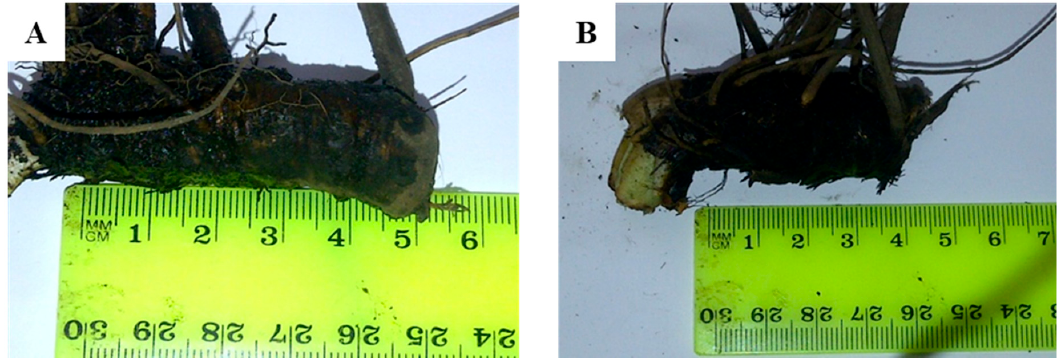
Figure 1. Different lengths of rhizome stocks of A. amatymbica , ( A ) 5 cm rhizome stock ( B ) 4 cm rhizome stock.